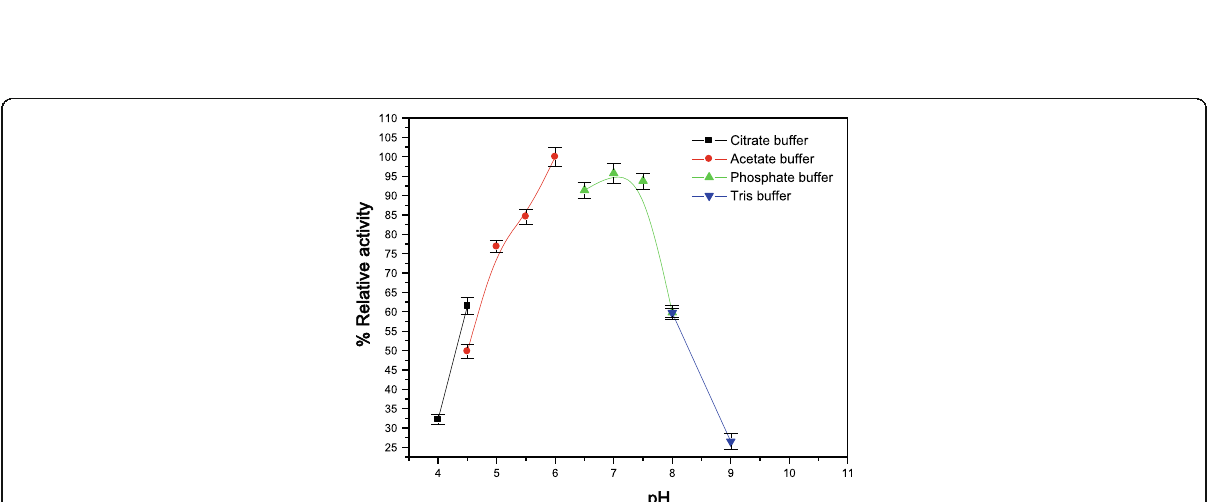
Fig. 5 Lineweaver-Burk plots relating ginger GPII reaction velocities to H 2 O 2 and guaiacol